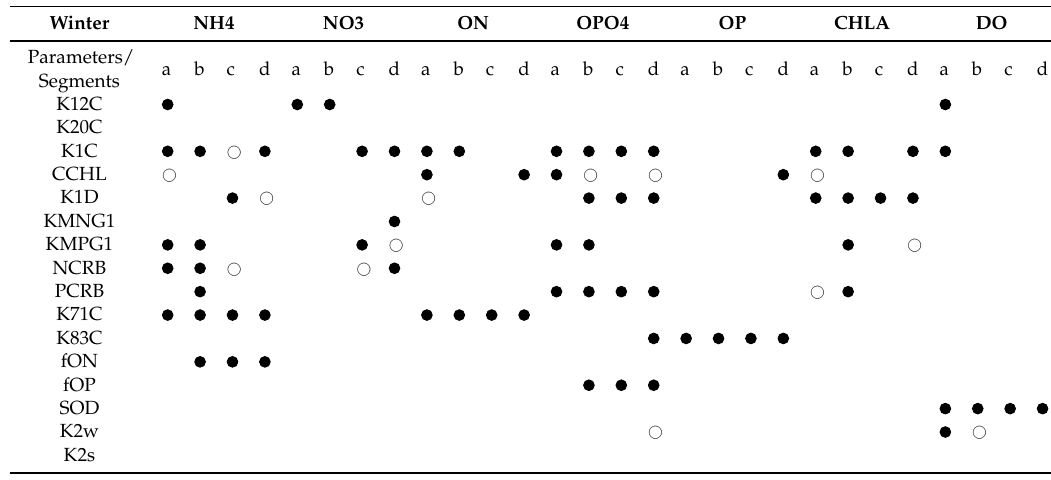
Table 3. Sensitivity analysis in summer.